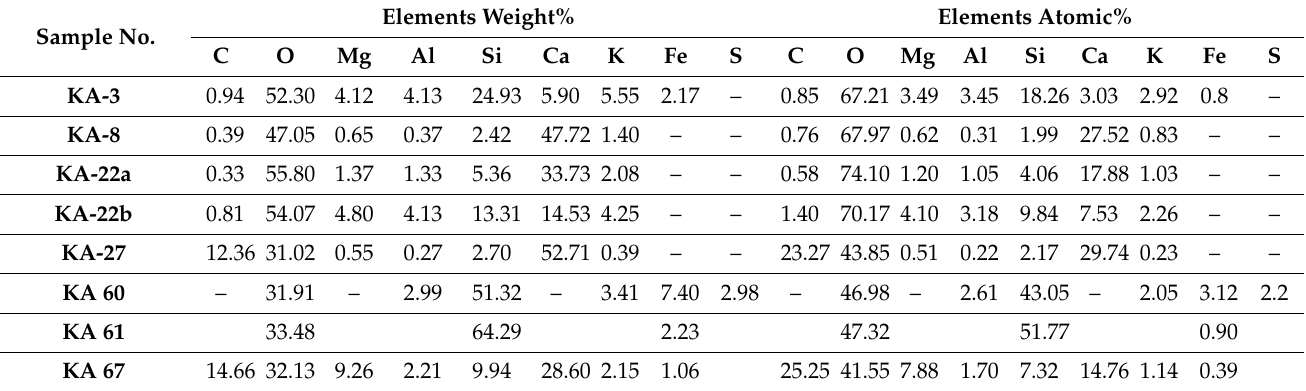
Table 4. Energy dispersive X-ray (EDX) percentage of elements present in samples of the Abbottabad